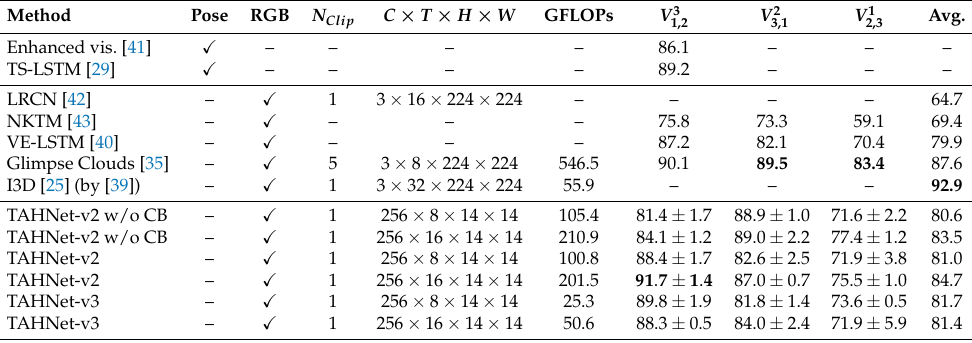
Table 2. Comparison results with the SOTA methods on the N-UCLA dataset.